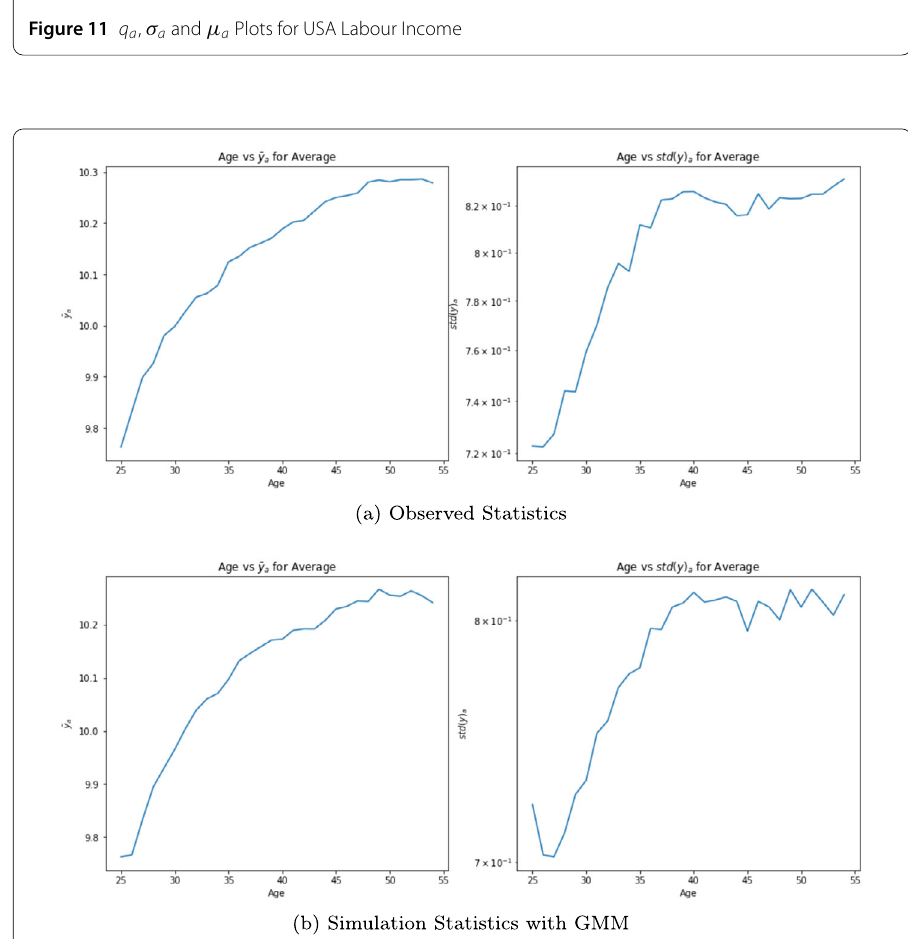
Figure 12 USA Labour Data Observed and Simulation